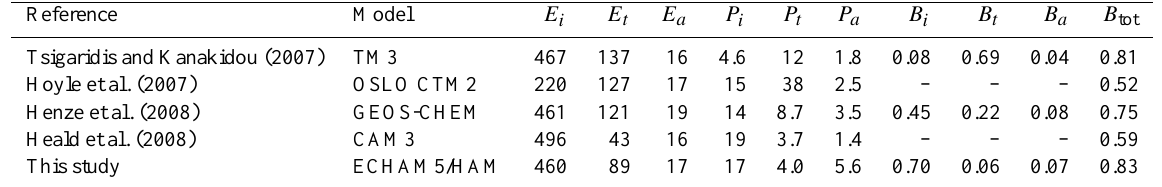
Table 4. Model estimate of SOA precursor emission, SOA production and atmospheric burden. E : emissions (Tgyr − 1 ), P :